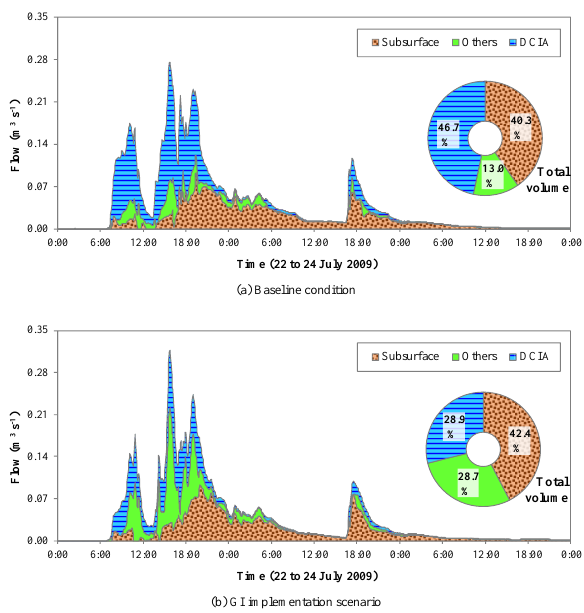
Figure 13. Hydrograph separation and volumetric percentages con- tributing to stream flow for the period 22 to 24 July 2009.